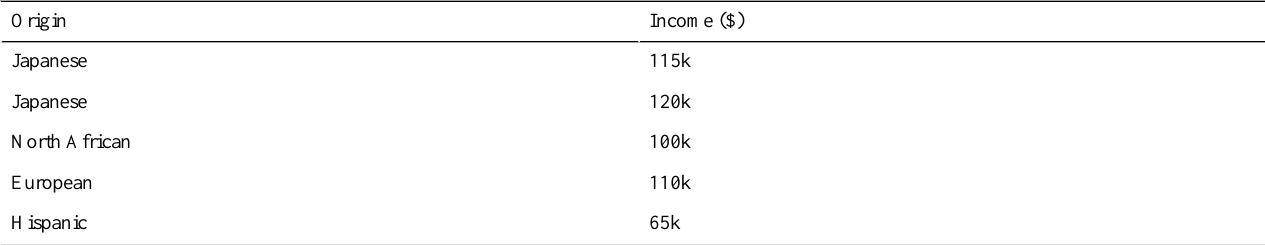
Table 3. Example of a synthetic sample, with one’s origin as the quasi-identifier and one’s income as the sensitive